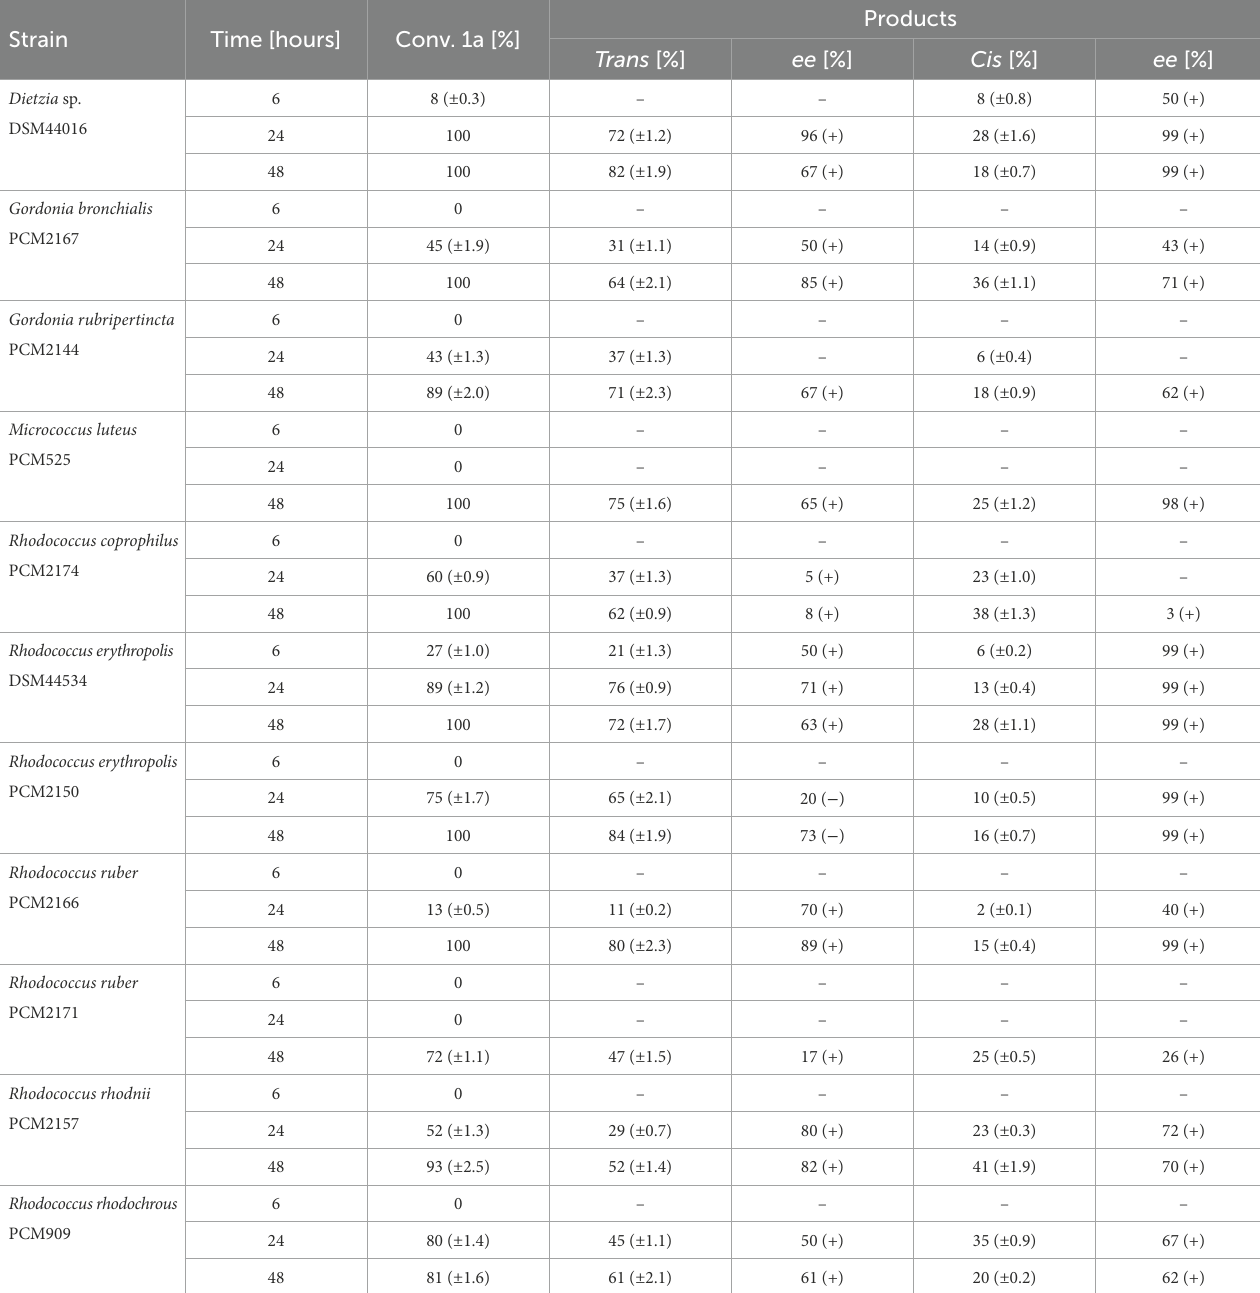
TABLE 1 Results of the microbial oxidation of anti -3-methyloctane-1,4-diol (1a) in MTPs.